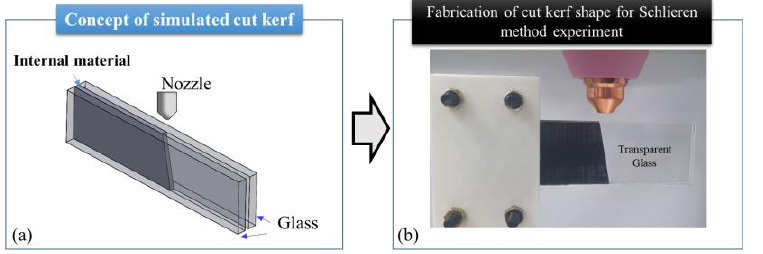
Figure 2. Kerf structure fabrication for the Schlieren experiment. ( a ) Conceptual model for simulated kerf. ( b ) Fabricated kerf slot.